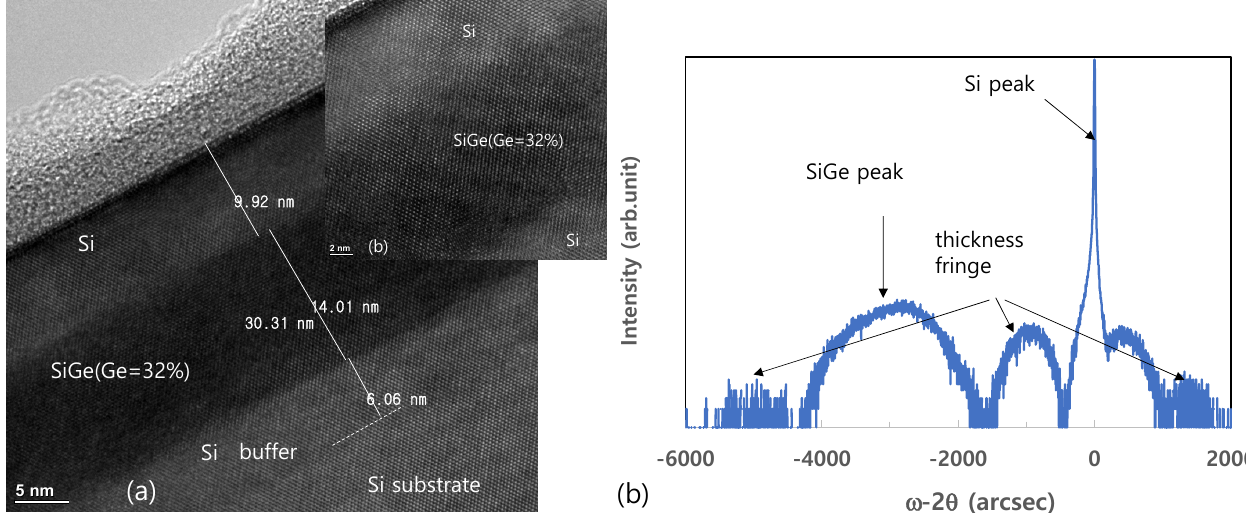
Figure 8. The TEM image and high resolution X-ray diffraction (HRXRD) of the Si (10 nm)/SiGe (14 nm)/Si (6 nm) epitaxial films obtained after wet pre-cleaning and subsequent H 2 bake at 700 °C. ( a ) TEM image ( b ) HRXRD rocking curve (Si and SiGe peaks are shown).